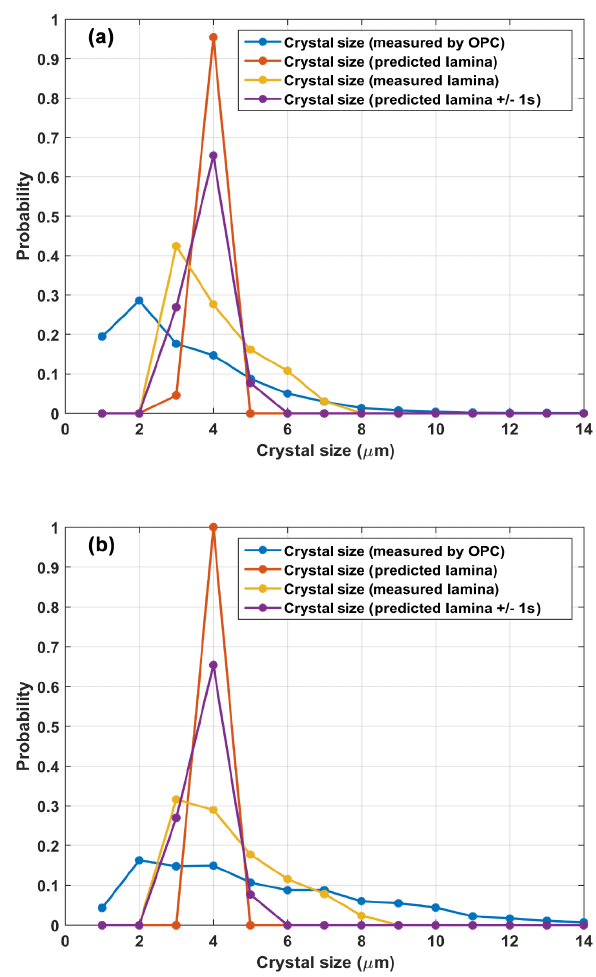
Figure 7. Probability histogram of ice crystal diameter. Both exper- iments were conducted at − 40 ◦ C with (a) at 102% RH and (b) at 110% RH, both with respect to liquid water. In the predicted case all particles are assumed to remain within the lamina, nucleate ice and grow to the same final size (red). The ice crystal size distribu- tion becomes broader if particles are allowed to exist in the cham- ber for 1s shorter or longer than predicted (purple). Ice crystal size predictions using the spreading time indicated in Fig. 2 results in the yellow histogram. Note that the ice crystal size predictions us- ing the measured spreading time (yellow) most closely matches the measured ice crystal size distribution (blue) from the ZINC